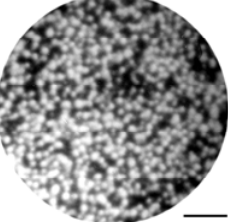
Figure 1. The FIM image of a Zr field evaporation in high vacuum to a depth of about 50 nm. The scale bar is 5 nm.